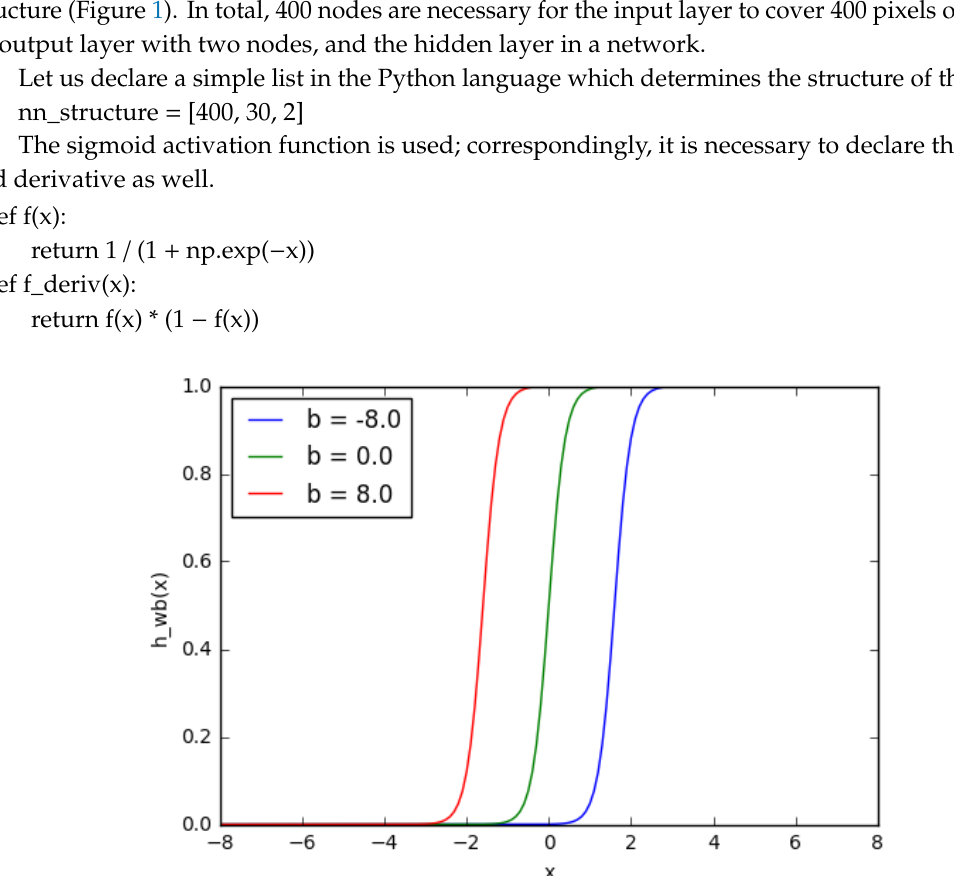
Figure 10. A node with displacement at the input.